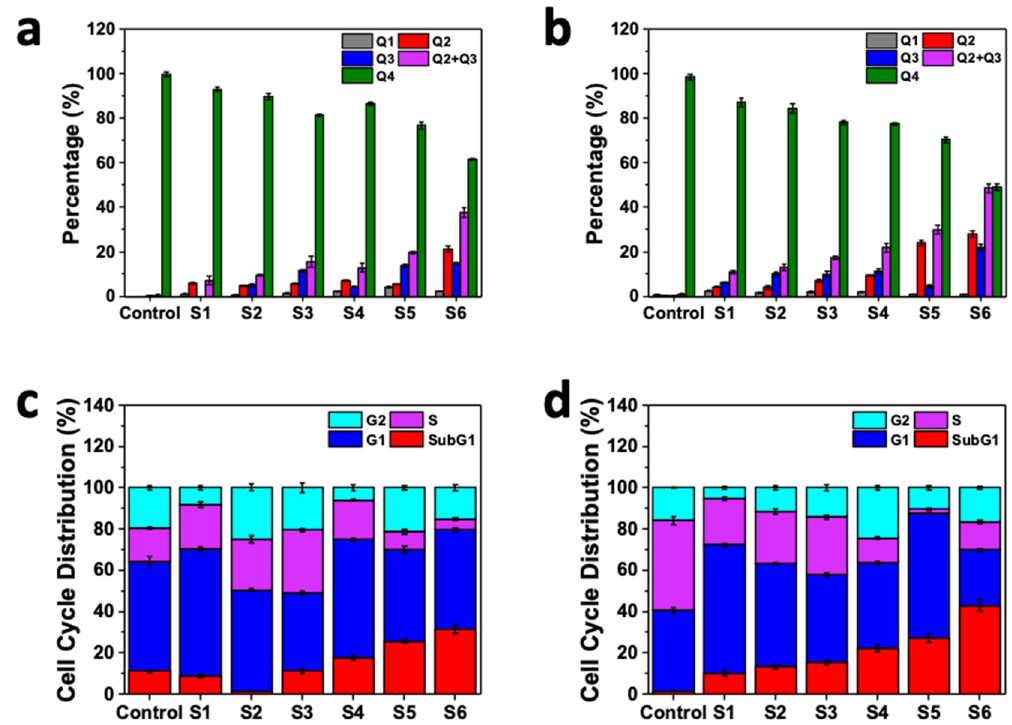
Figure 5. Analysis of the apoptosis rate in ( a ) MDA-MB-231 and ( b ) SK-BR-3 cancer cell lines after incubation with different samples. Q1 (necrotic cells), Q2 (late apoptosis), Q2 + Q3 (early apoptosis), and Q4 (alive cells). Treatments of range concentrations (IC50 concentration) of nano- and free drugs were applied to the cells for 48 h. Cell cycle analysis for ( c ) MDA-MB-231 and ( d ) SK-BR-3 cancer cell lines after incubation with different samples. S1: letrozole; S2: curcumin; S3: mixture of letrozole and curcumin; S4: NiCoFe 2 O 4 @L-Silica@Niosome; S5: NiCoFe 2 O 4 @L-Silica@L-Niosome; S6: NiCoFe 2 O 4 @L-Silica@C-Niosome. Control: untreated cells.